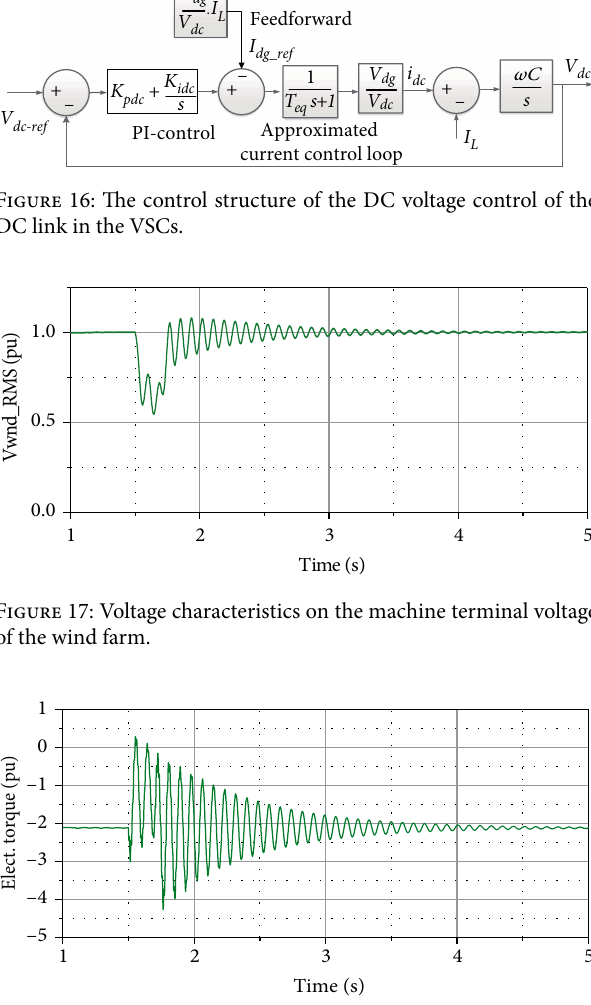
Figure 18: The electrical torque characteristics of the wind farm.